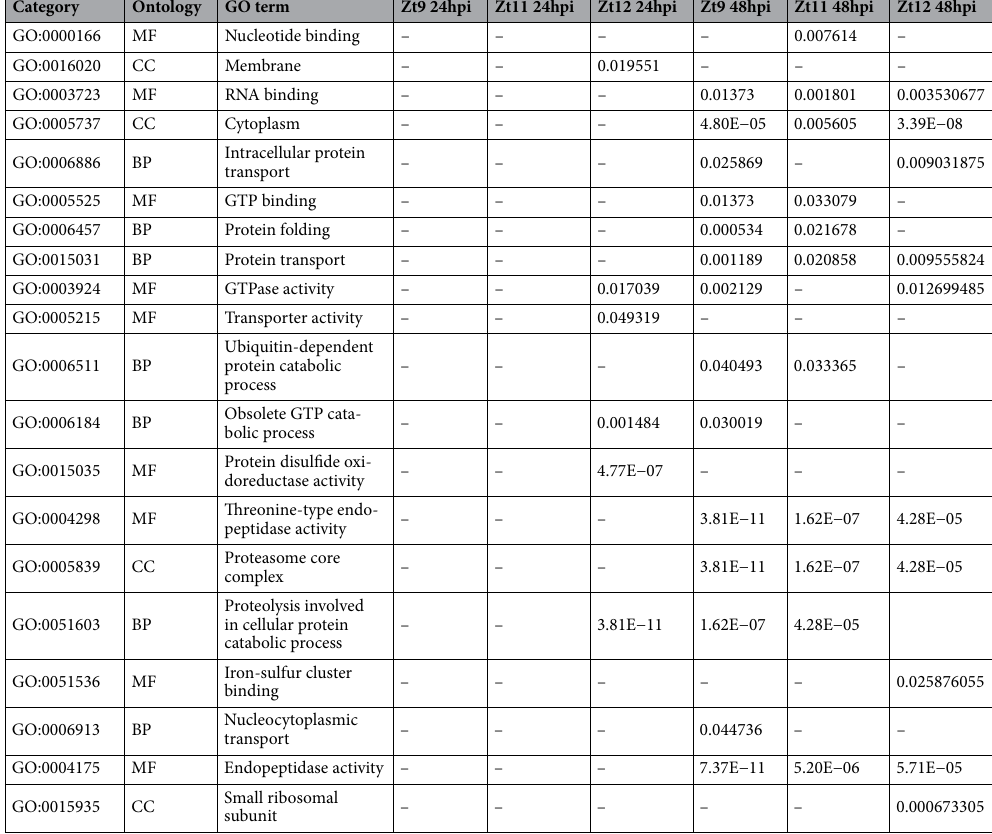
Table 4. Top 20 GO terms enriched among SSP treatments in upregulated DEGs and their BH-FDR adjusted P